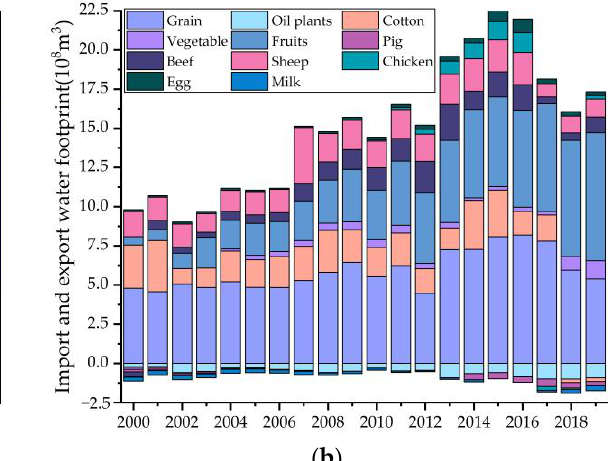
Figure 4. Percentage of different agricultural products in Hotan region.